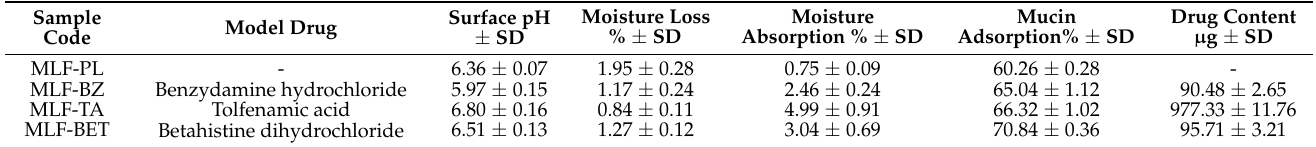
Table 2. Characteristics of multilayer casein/chitosan films loaded with benzydamine hydrochloride (MLF-BZ), tolfenamic acid (MLF-TA) and betahistine dihydrochloride (MLF-BET) compared to drug-free (placebo) films (MLF-PL), n =